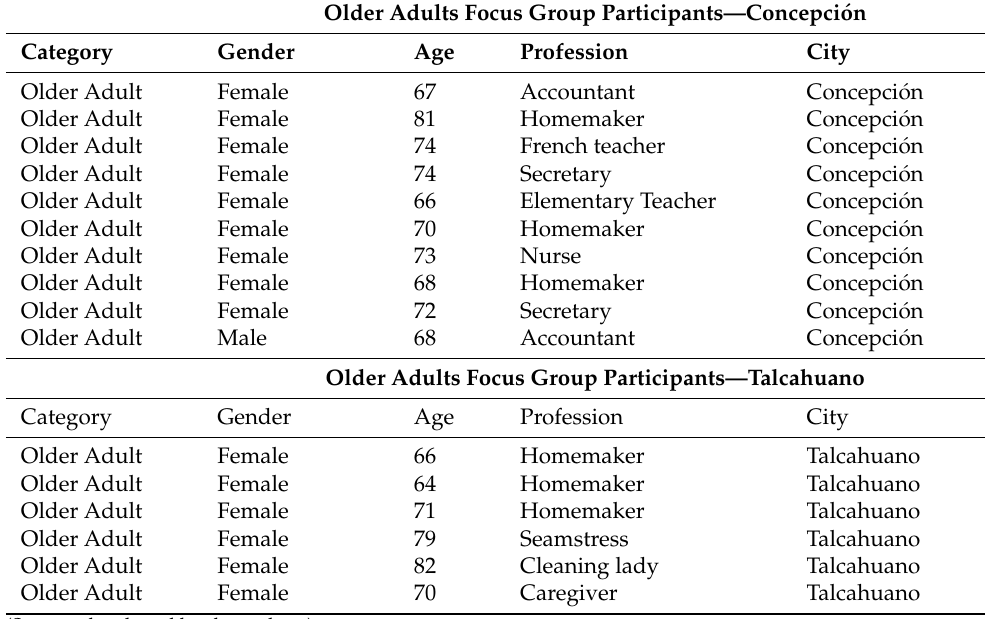
Table A1. Focus group participants of the study (part 1).